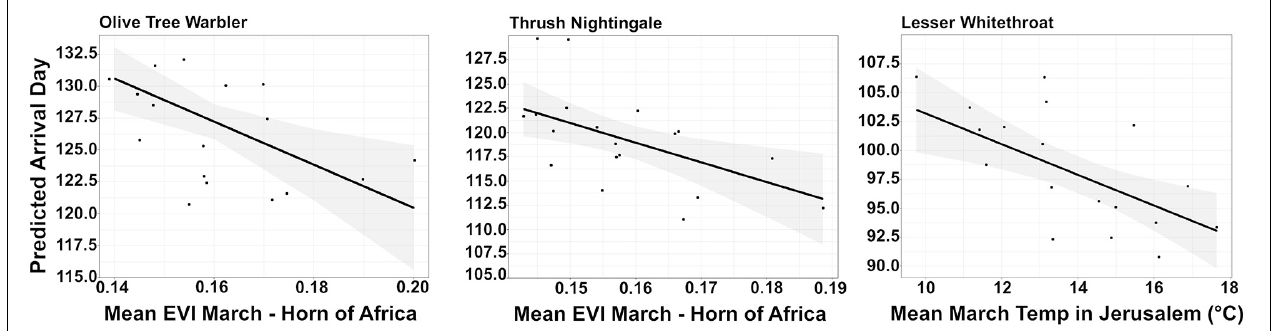
FIGURE 4 | The relationship between mean arrival day and average Enhanced Vegetation Index (EVI) on the Horn of Africa and temperatures in March at the stopover site in Jerusalem. Predicted lines were drawn from a linear model and only variables considered important by the multi-model approach are shown. Black points represent raw data and the 95% confidence interval is shown in grey. The lines in each plot are derived from different species-specific linear models outlined in the